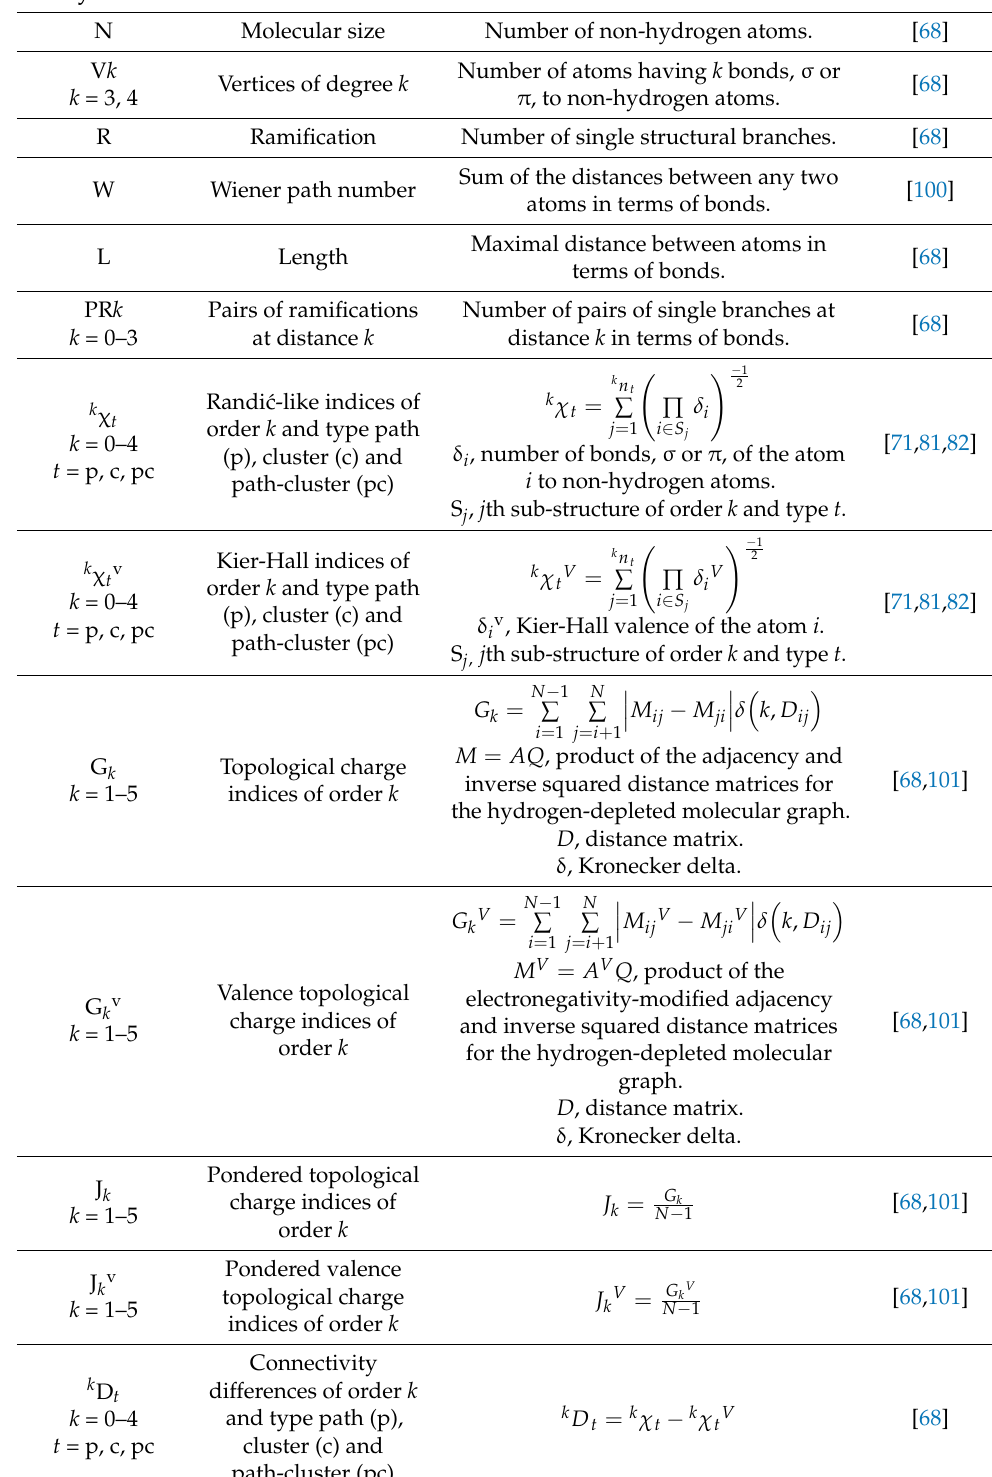
Table 1. Descriptors